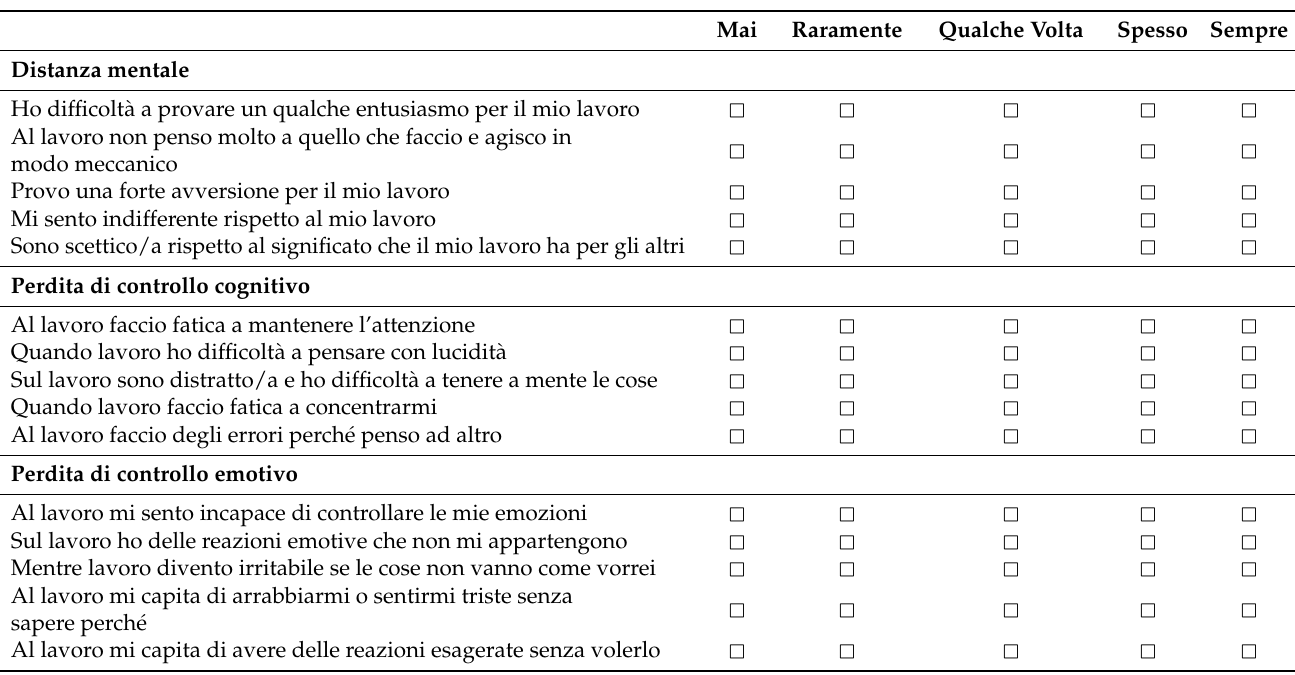
Table A1. Cont. Mai Raramente Qualche Volta Spesso Sempre